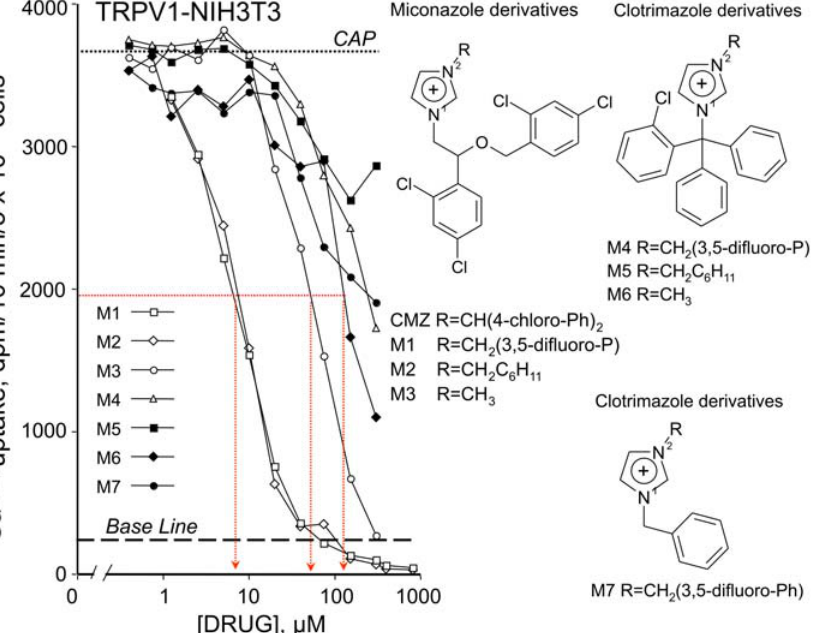
Figure 2. Screening of other calmidazolium analogs (M-set). Among miconazoles, clotrimazole, and N-benzylimidazole compounds (M1–M7) calmidazolium was the most potent inhibitor in TRPV1-NIH3T3 cells. Each point on the graph is the average of triplicate determinations. Chemical structure of miconazoles, clotrimazole, and N-benzylimidazole compounds used in these studies are indicated. Experiments were repeated two additional times in triplicate with similar results.